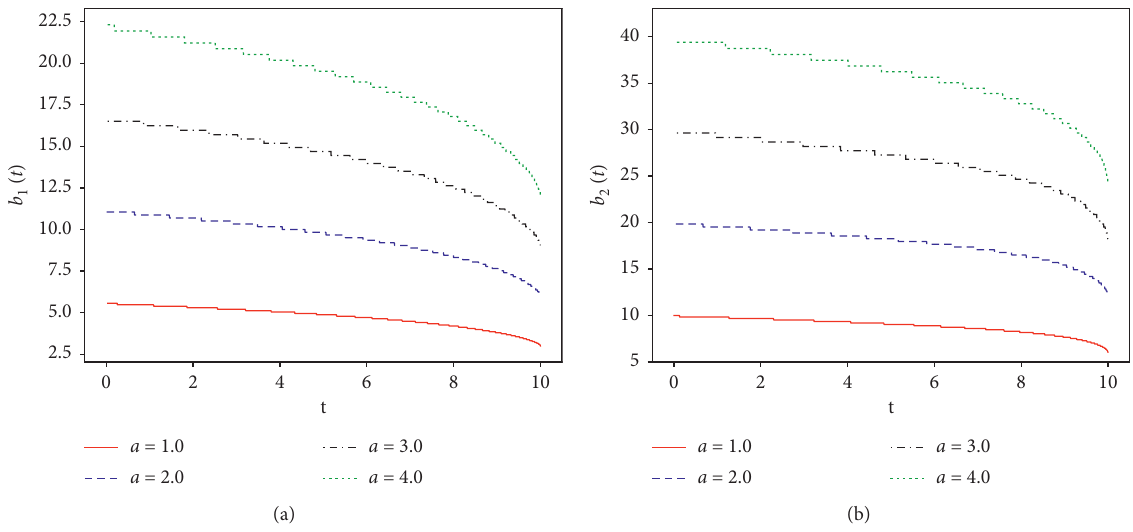
Figure 2: The impact of varying transaction fee on the early exercise boundary for (A.) regime 1 and (B.) regime 2.